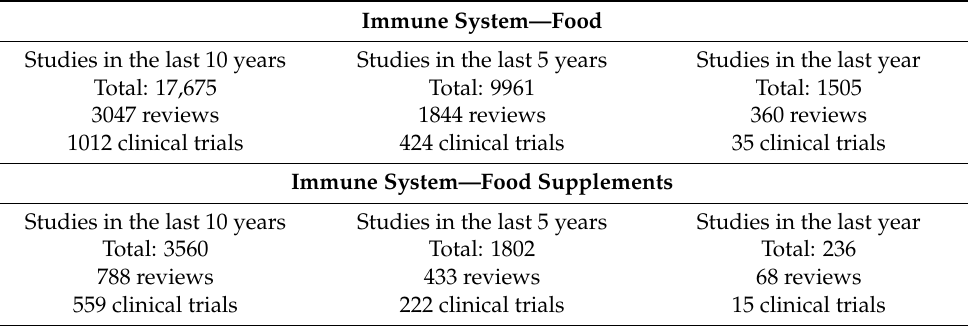
Table 2. Summary of the studies found in PubMed by using ‘immune system’, ‘food’, and ‘food supplements’ as